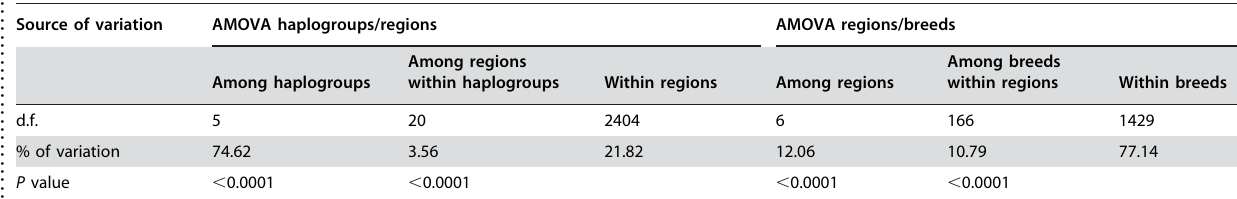
Table 3. Partition of the genetic variance among haplogroups, breeds and continental regions revealed by hierarchical AMOVAs .. ... .... ... ... .... ... ... .... ... ... .... ... ... .... ... ... .... ... ... .... ... ... .... ... ... .... ... ... .... ... ... .... ... ... .... ... ... .... ... ... .... ... ... . Source of variation AMOVA haplogroups/regions AMOVA regions/breeds Among regions Among breeds Among haplogroups within haplogroups Within regions Among regions within regions Within breeds